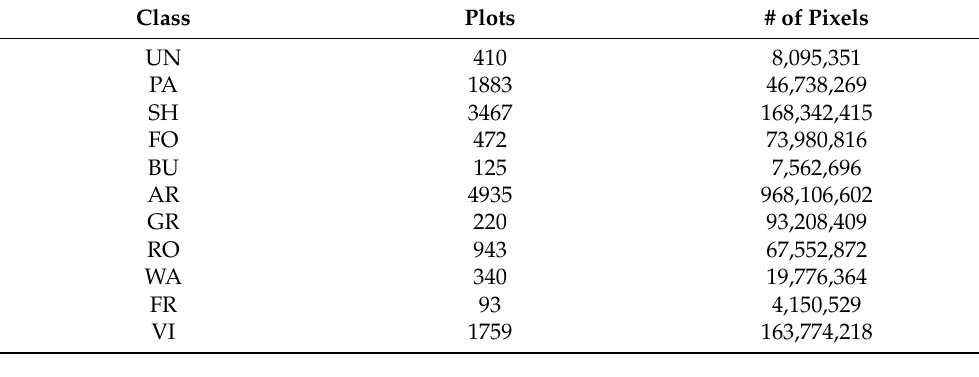
Table 2. Number of SIGPAC plots and pixels for each class used in UOPNOA.